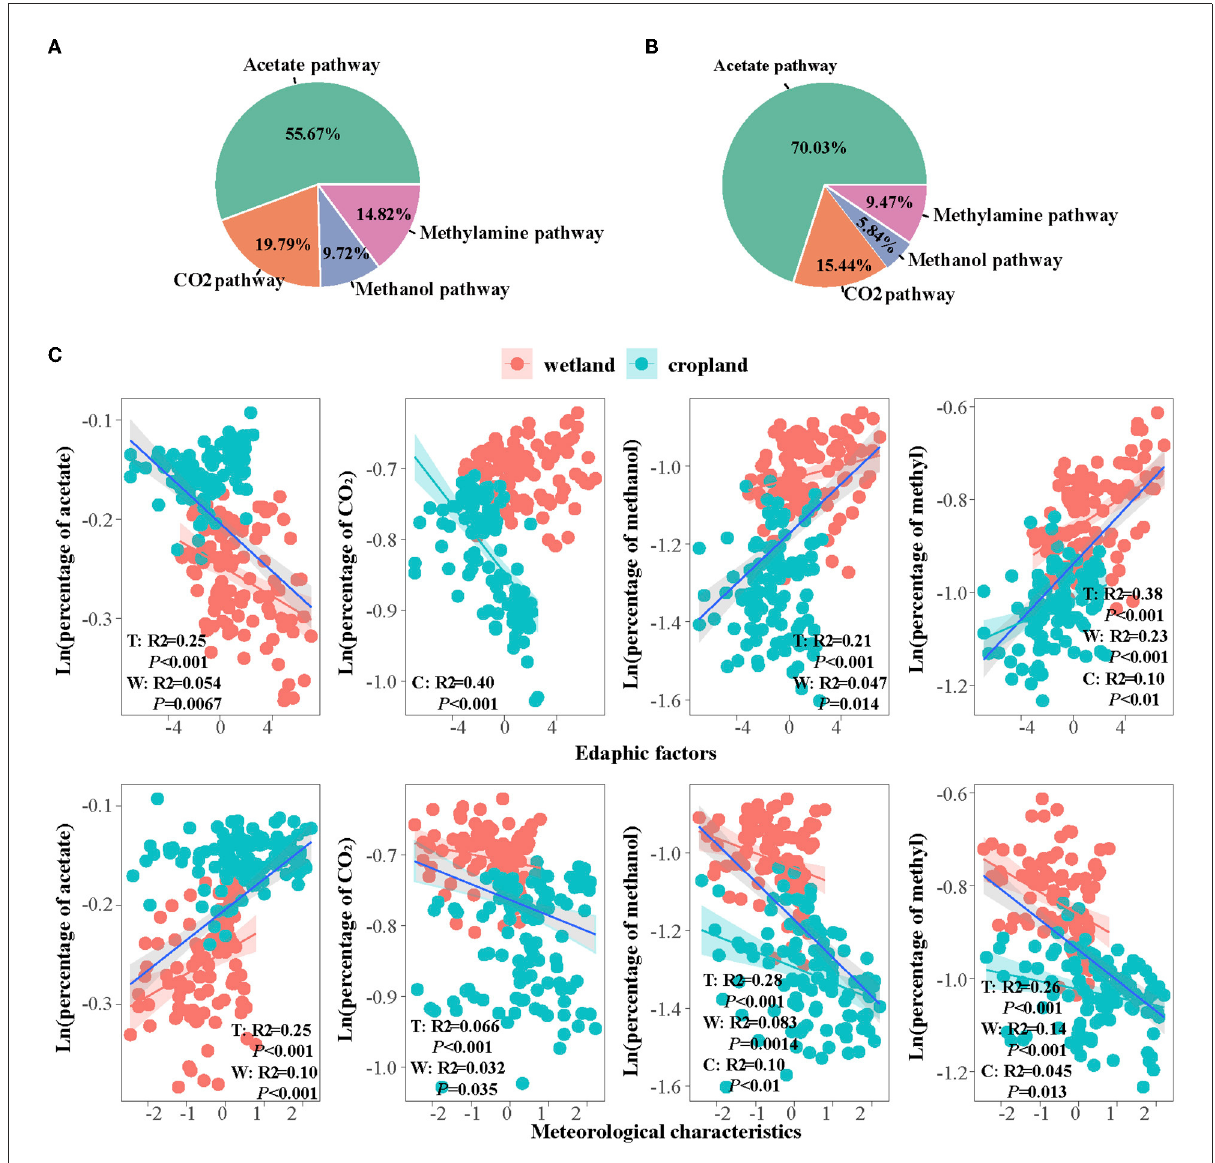
FIGURE6 Percentage of four pathways in (A) wetland and (B) cropland; and the correlations of four pathway percentages with edaphic and meteorological factors (C) . T, total; W, wetland; C, cropland.